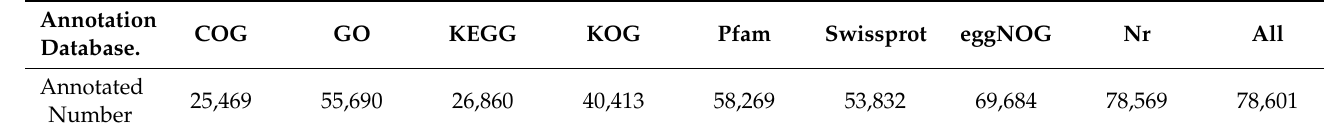
Table 1. Gene annotation statistics.